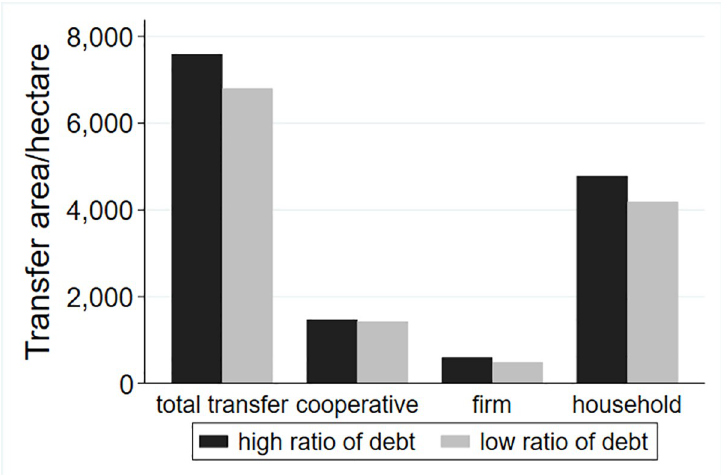
Fig 2. Land transfer scale in the regions with different total per capita